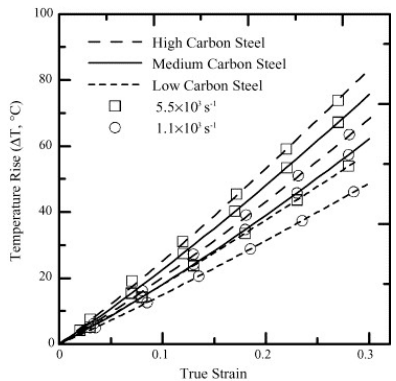
Figure 23. Temperature vs. true strain for three kinds of steels at different strain rates [123] .